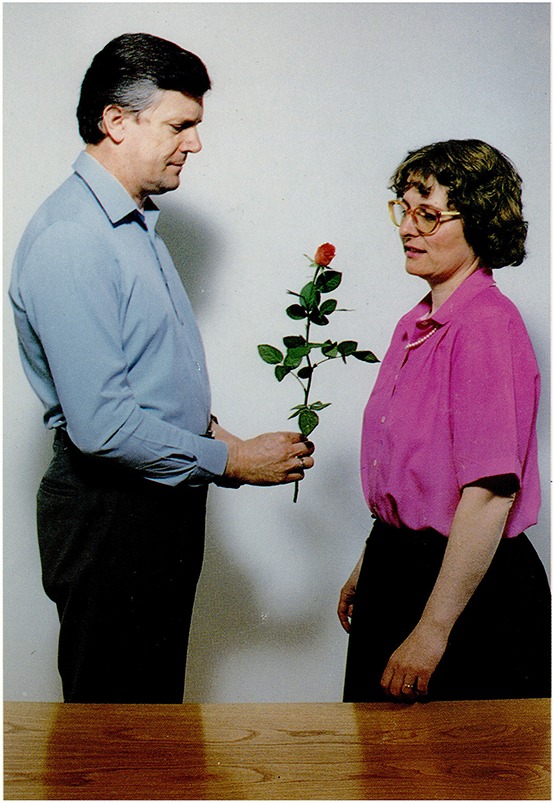
A man is giving a flower to a woman (Stark, 1998).